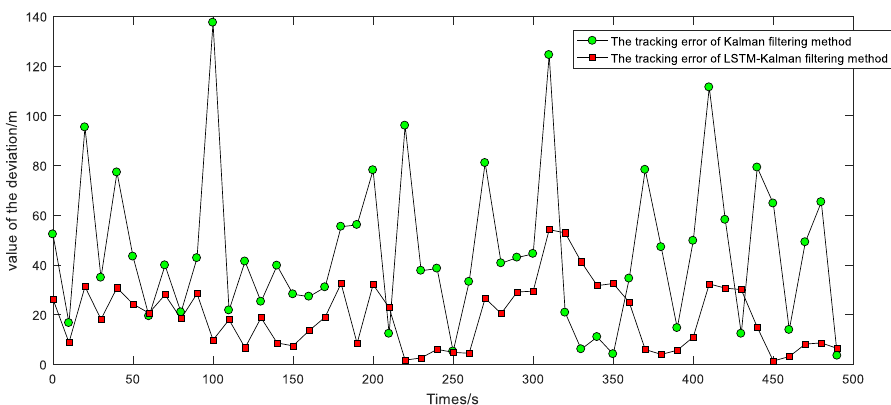
Figure 16. Comparison diagram of the target tracking deviations between the Kalman filtering method and the LSTM–Kalman filtering method.